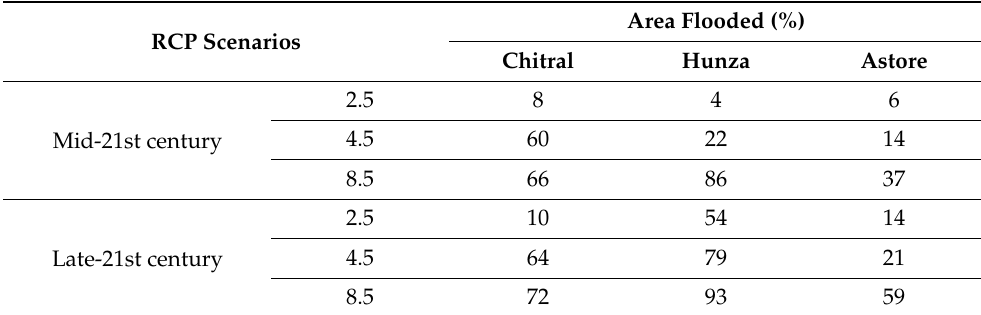
Table 1. Area flooded (%) within the studied portions of the three basins under RCP mid- and late-21st century scenarios.